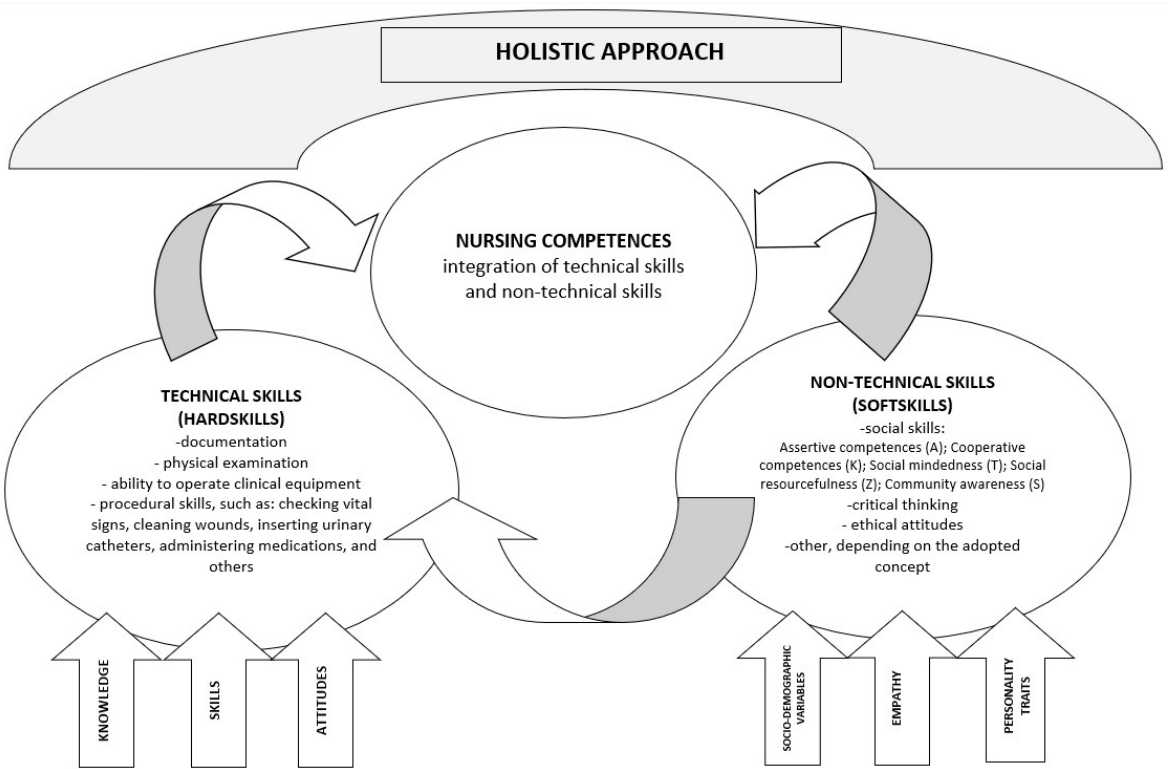
Figure 1. Conceptual model: A holistic approach to nursing competences.